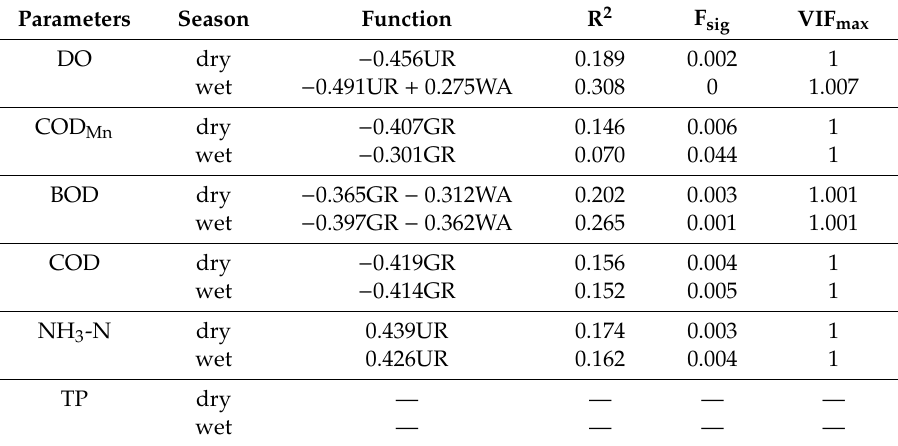
Table 5. Regression analysis of water quality parameters and land use percentage. Parameters Season